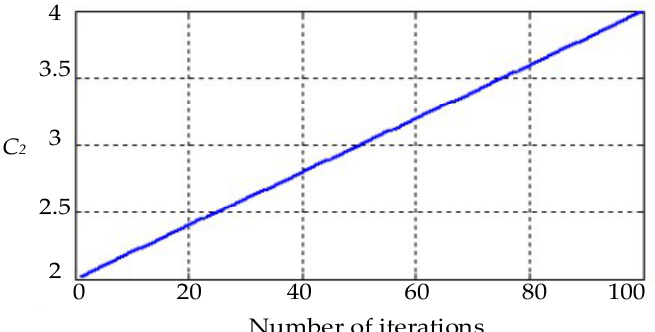
Figure 5. Trend of social learning factor C 2 combining ABC and PSO. Table 1. Parameter setting value of traditional particle swarm optimization (PSO).